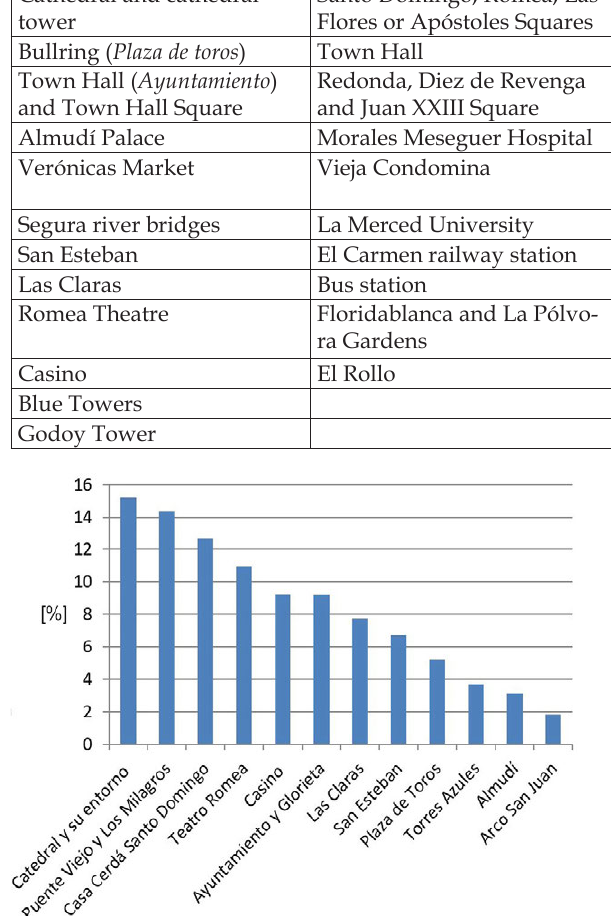
Fig. 3. A collective map of Murcia made by a group of 8 students presenting their perception about paths ( sendas ), landmarks ( hitos ), nodes ( nodos ) and districts ( barrios ). It highlights Murcia center-east because it is the traditional university leisure district. At the South, the Segura river as a border. Table 2. Murcia elements highlighted by respondents in the categories established by Lynch (1960). Landmarks Nodes Paths Edges or Borders